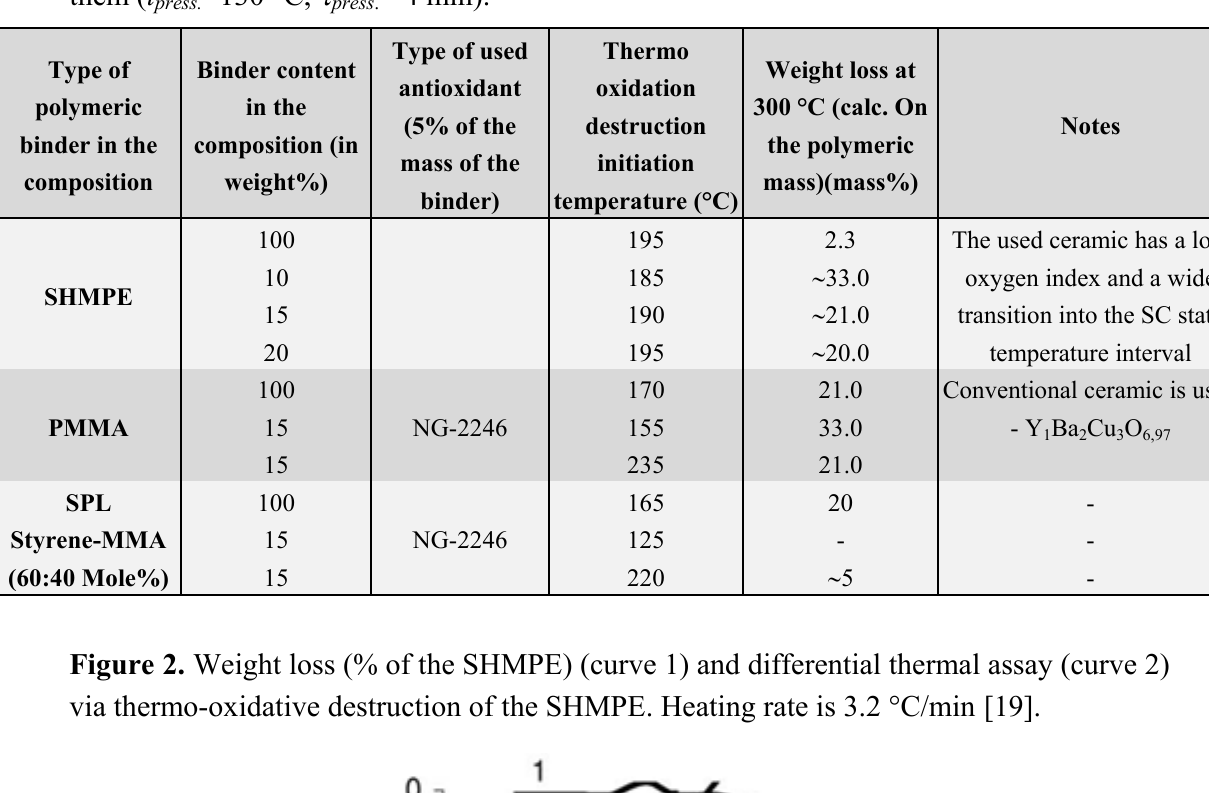
Table 3. Thermo stability of the polymeric binders and of SC nanocomposites based on =130 ° C, τ = 4 min). them ( t press. press .